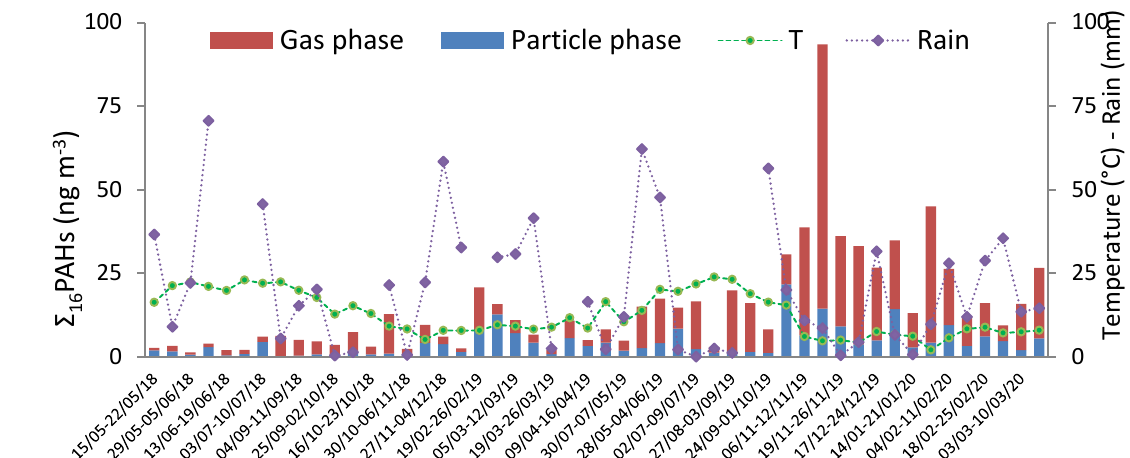
Figure 1. Annual variations of gas and particulate phase PAH concentrations and temperatures from 15 May 2018 to 17